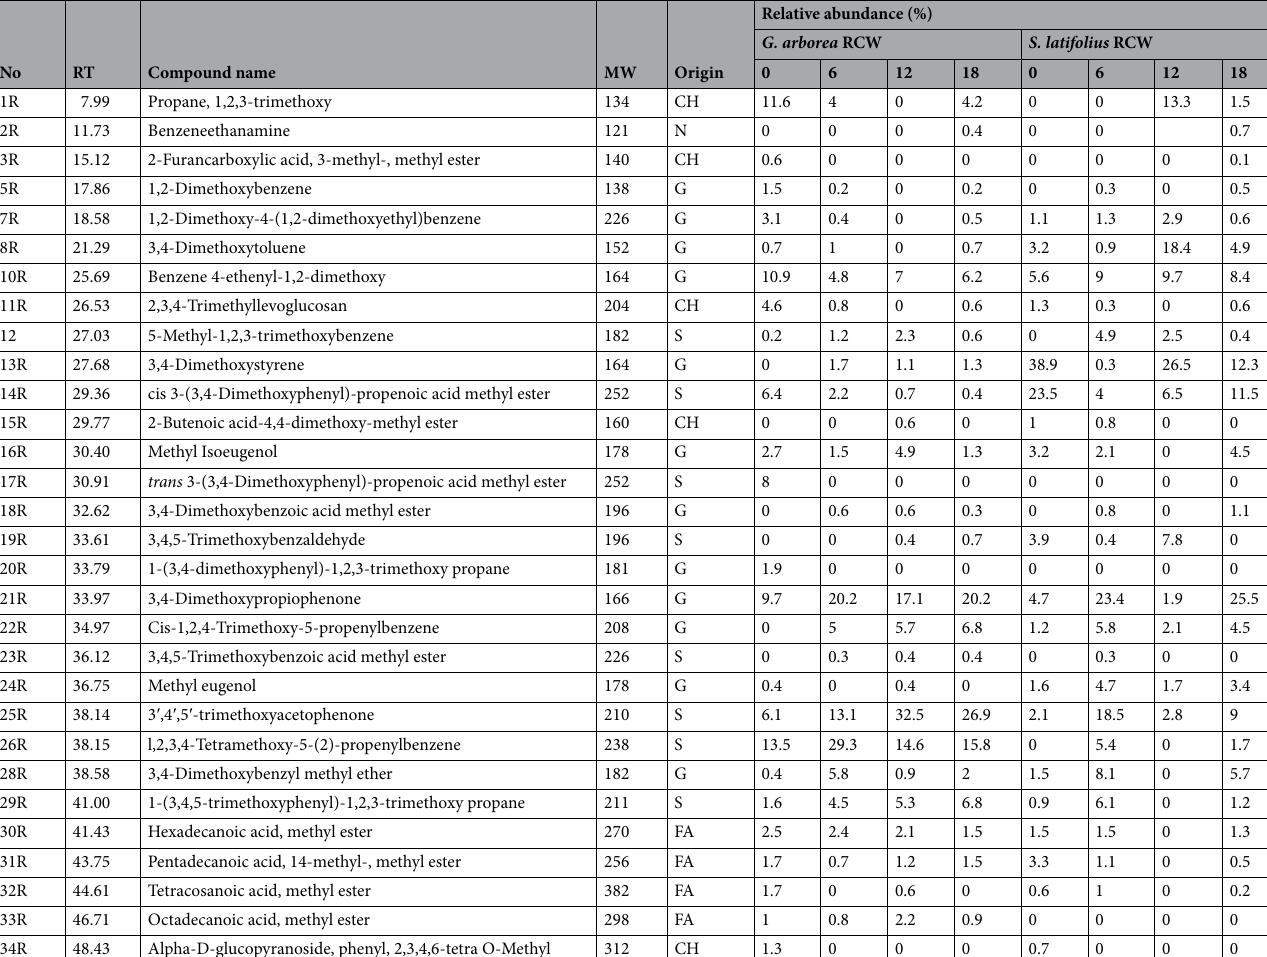
Table 1. Identity and relative molar abundances of the compounds released after THM from the RCW samples at different durations of soil incubation; values are averages of triplicate measurements. Each peak number is followed by R to refer to RCW. RT, retention time